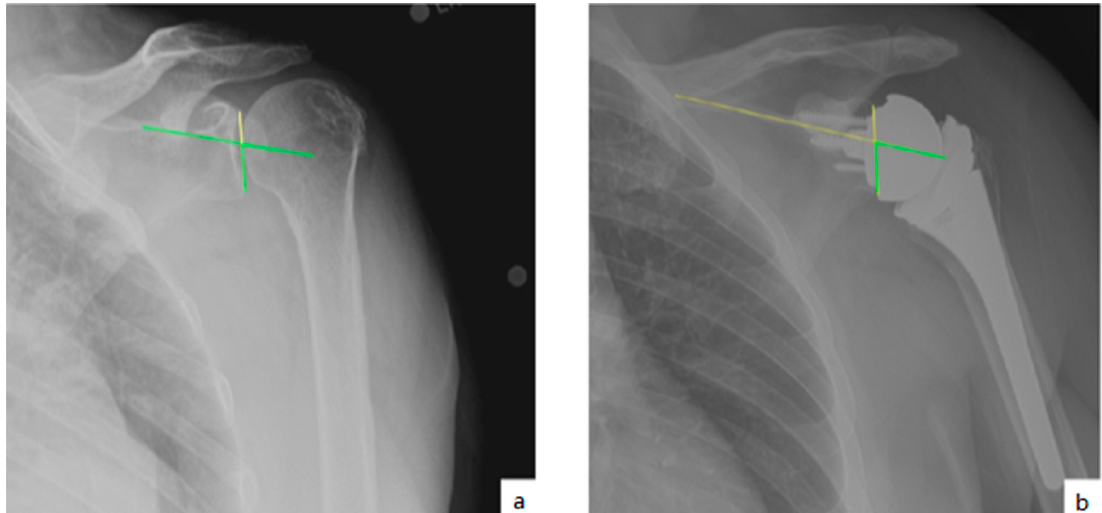
Figure 4. ( a ) Glenoid inclination (green angle); ( b ) baseplate inclination (green line) .